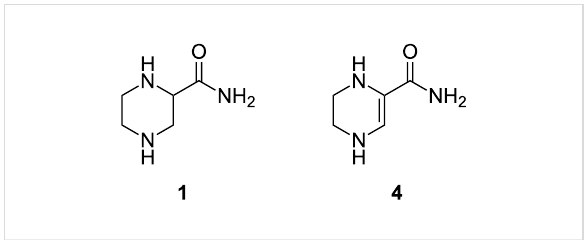
Figure 10: Reduction products of piperazine-2-carboxamide.